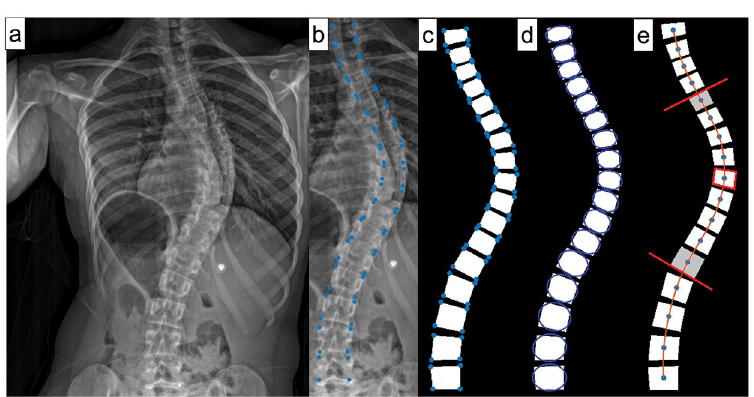
Fig 1. Steps of Cobb angle measurement from frontal radiographs. a. Plain frontal X-ray b. Four LMPs were selected per vertebra c. Polygon fit through each vertebra vertices (LMPs) d. Best fit ellipse through each polygon to calculate the orientation of each vertebra as the angle between the major axis of the ellipse and the horizontal e. A cubic spline was fit through the centroids of the vertebrae, the most tilted vertebrae above and below the apical level were identified, and the Cobb angle was calculated between these